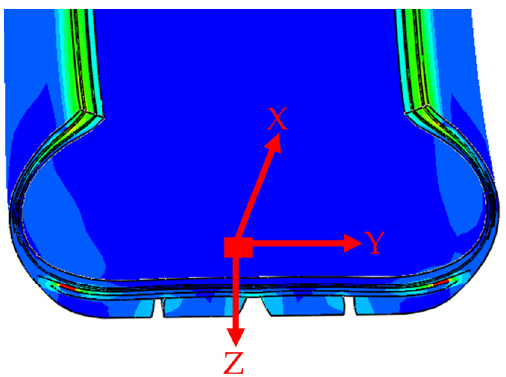
Figure 4. Schematic diagram of the position of the three-axis accelerometer.